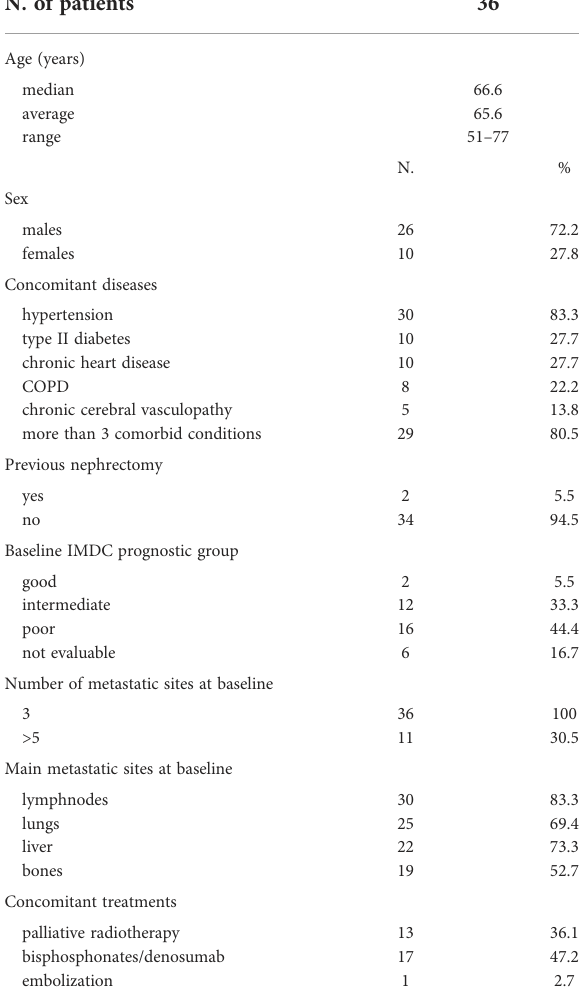
TABLE 1 Patients ’